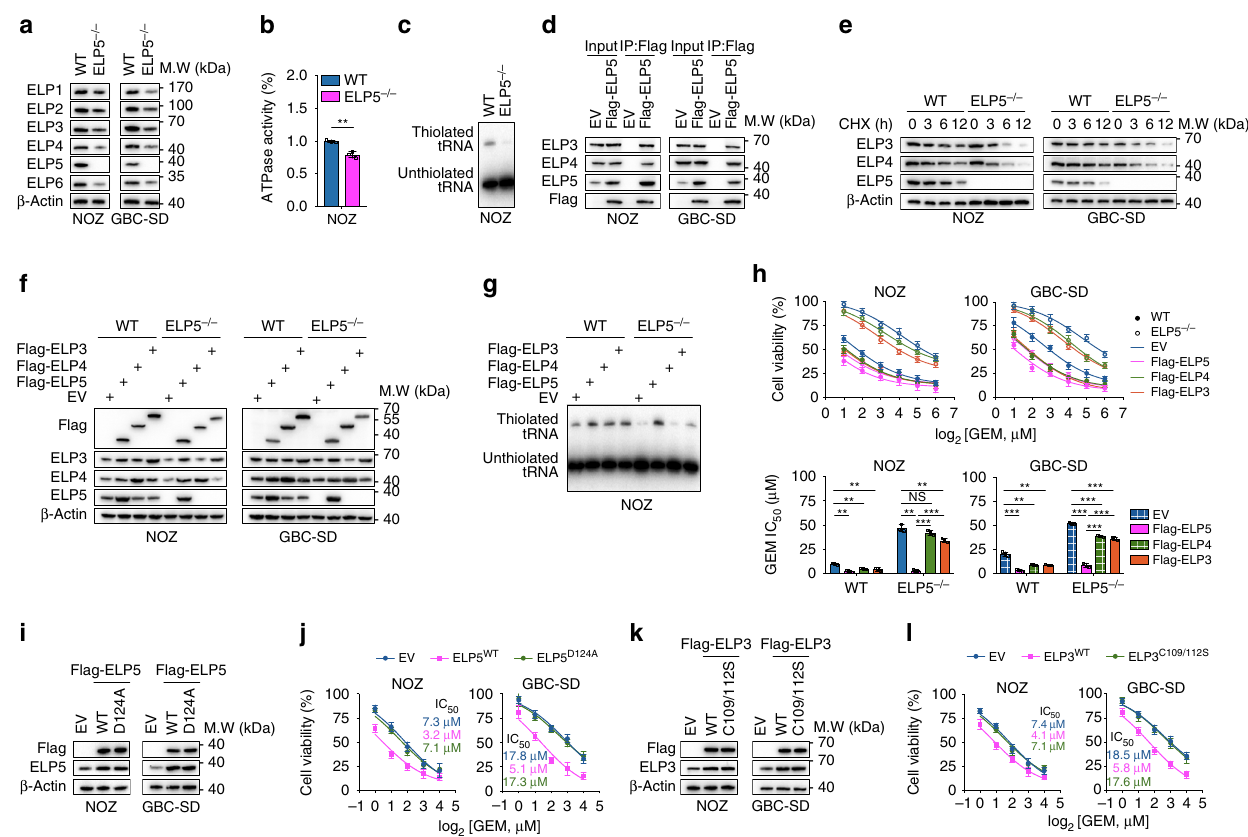
Fig. 3 The integrity and stability of the Elongator complex are required for gemcitabine-induced cytotoxic effects in GBC cells. a ELP5 depletion signi fi cantly downregulated the protein levels of other Elongator subunits, including ELP1, ELP2, ELP3, ELP4, ELP6. b ELP5 depletion signi fi cantly decreased ATPase activity in NOZ cells. c The abundance of thiolated tE UUC tRNA was decreased in ELP5 -depleted NOZ cells. d Ectopically expressed ELP5 could interact with ELP3 and ELP4 in GBC cells. e Endogenous ELP3 and ELP4 degraded rapidly after treatment with 50 µ g ml − 1 cycloheximide (CHX) in ELP5 -depleted GBC cells compared with WT cells. f – h Ectopically expressed ELP5 ( f ) could promote or rescue thiolated tRNA abundance ( g ) and GEM sensitivity ( h ) in WT and ELP5 -depleted GBC cells, but ectopically expressed ELP3 or ELP4 ( f ) could only increase the abundance of thiolated tRNA ( g ) and GEM sensitivity ( h ) in WT cells, not in ELP5 -depleted cells. i , j Mutation of the ATPase activity site residue within ELP5 (D124A) ( i ) could not promote GEM sensitivity in GBC cells ( j ). k , l Mutation of the cm 5 U catalytic activity site residue with ELP3 (C109/112 S) ( k ) could not promote GEM sensitivity in GBC cells ( l ). Data represent the mean ± S.D., n = 3 independent experiments in b , h , j , l , error bars represent S.D. Unpaired Student ’ s t -tests were used in b , h (NS, non- signi fi cant, ** P < 0.01 and *** P <